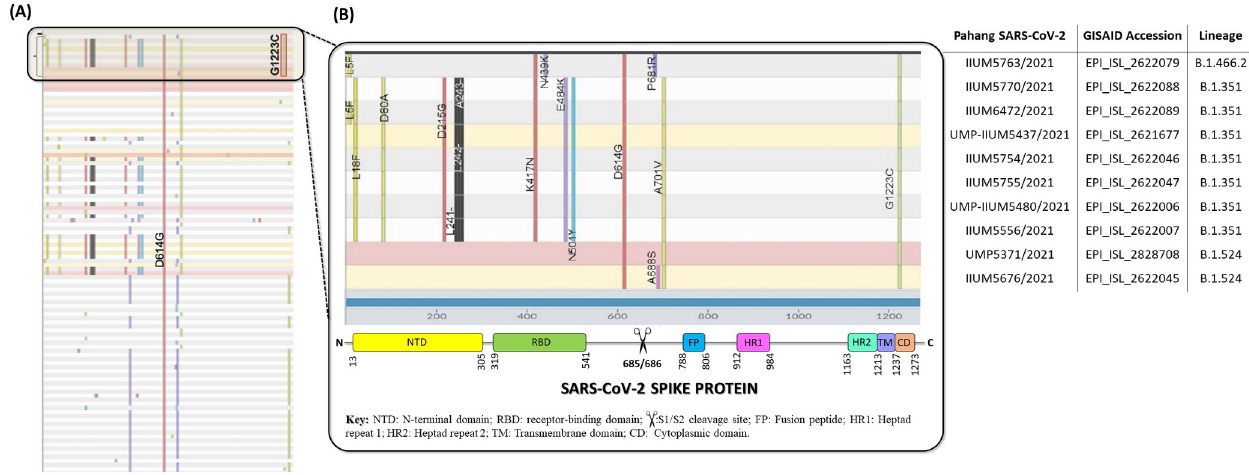
Fig 3. Nonsynonymous mutations in the spike protein of Malaysian SARS-CoV-2 D614G variants. (A) Nextstrain clade mutation analysis (vertical bars) of 986 Malaysian SARS-CoV-2 genomes, where Pahang SARS-CoV-2 D614G variants are highlighted in the box. Note the presence of unique mutation at G1223C in only Pahang SARS-CoV-2 D614G variants (B) Enlarged view of the Pahang SARS-CoV-2 D614G variants box where amino acid substitutions are annotated in the different regions of spike protein, schematically represented at bottom. Horizontal rows are correspondingly annotated with sample code, GISAID accession numbers and